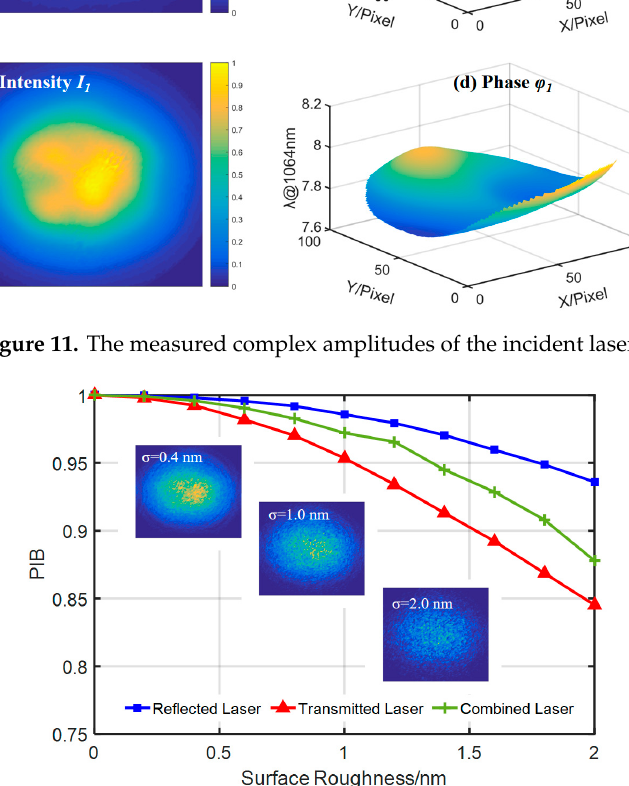
Figure 12. The encircled power versus surface roughness at a distance of 500 mm. The insets are the intensity profiles of the combined laser under di ff erent surface roughness